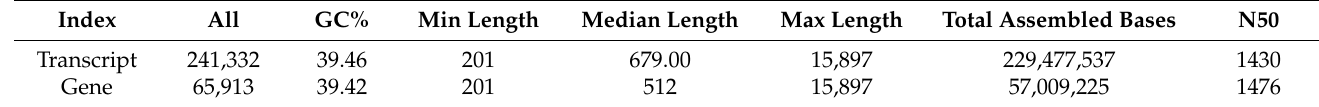
Table 2. Summary of assembly results of taproot in garden ginseng.